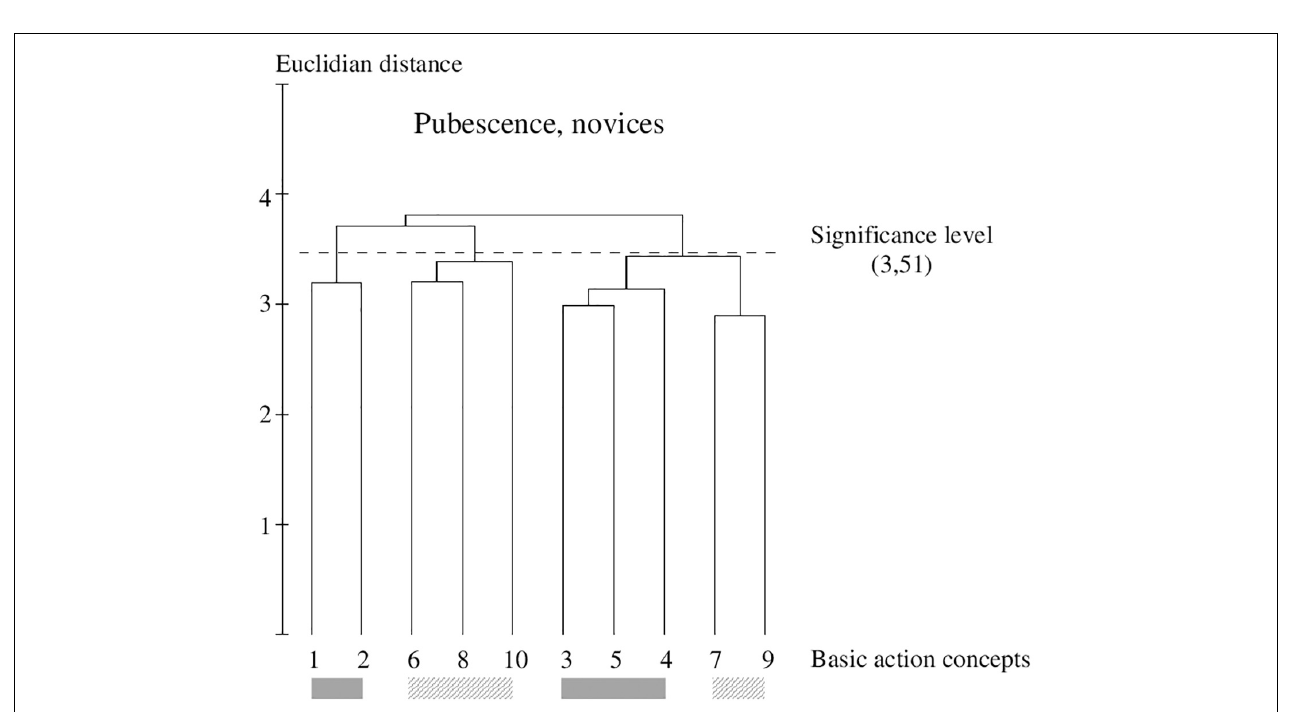
FIGURE 3 | Outcome of the hierarchical cluster analysis of novices within pubescence ( N = 17) displayed as a dendrogram. The dashed line clarifies the critical value of d crit = 3.51, which corresponds to a significance level of 5%. The BACs are marked with numbers among dendrogram and highlighted with the gray solid bar (technically correct BAC) and diagonally striped bar (faulty BAC).